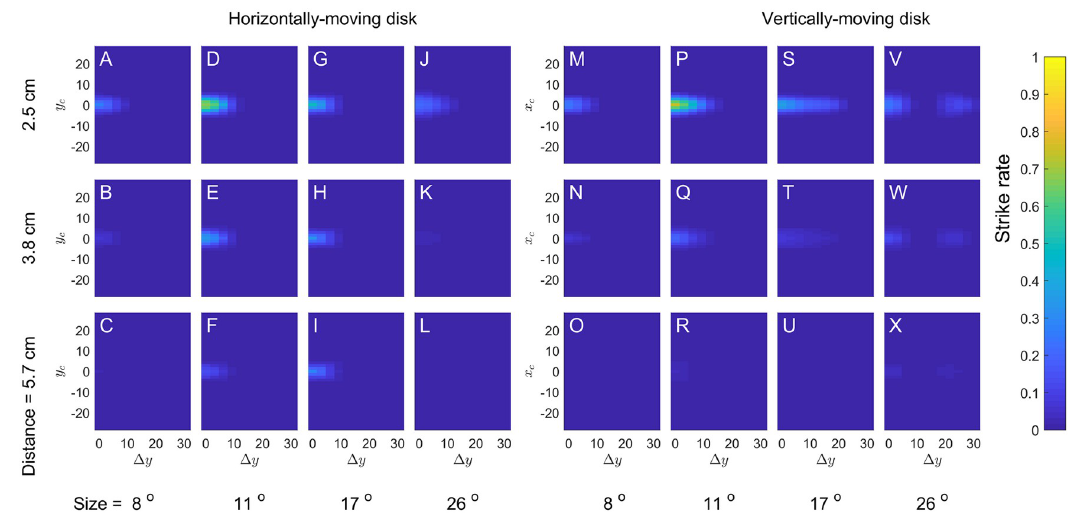
Fig 15. Predicted strike rate M (Eq 3) for disks moving horizontally (A-L) or vertically (M-X) in front of the model mantis, model as a function of vertical disparity Δ y and offset perpendicular to the direction of motion ( y and x c for vertically-moving). For the horizontally-moving targets, the vertical location of the target in the two eyes is constant at y L = y + Δ y /2 and y = y /2. For vertically-moving targets, the mean y -location is of course a function of time, but the difference y c R c − Δ y − y R is constant at Δ y . Different rows are for different disparities, thus simulating disks at different distances from the animal when Δ y = 0. Different columns are for different disk diameters.